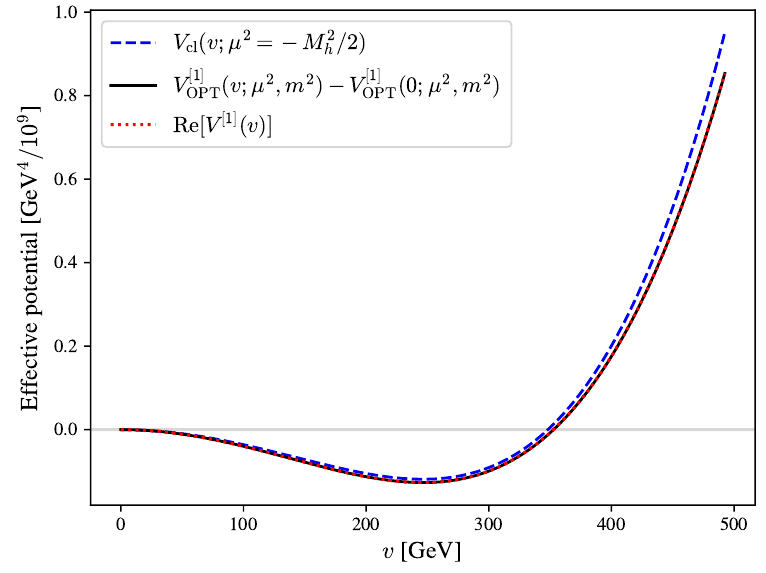
Figure 1 . Comparison of SM effective potentials. The OPT potential (black, solid) is compared to the real part of the potential obtained from parametrization via the pole mass (red, dotted), and the classical potential (blue, dashed). The OPT potential matches the one obtained from the parametrization via the pole mass to good accuracy: less than 1 % relative difference below the